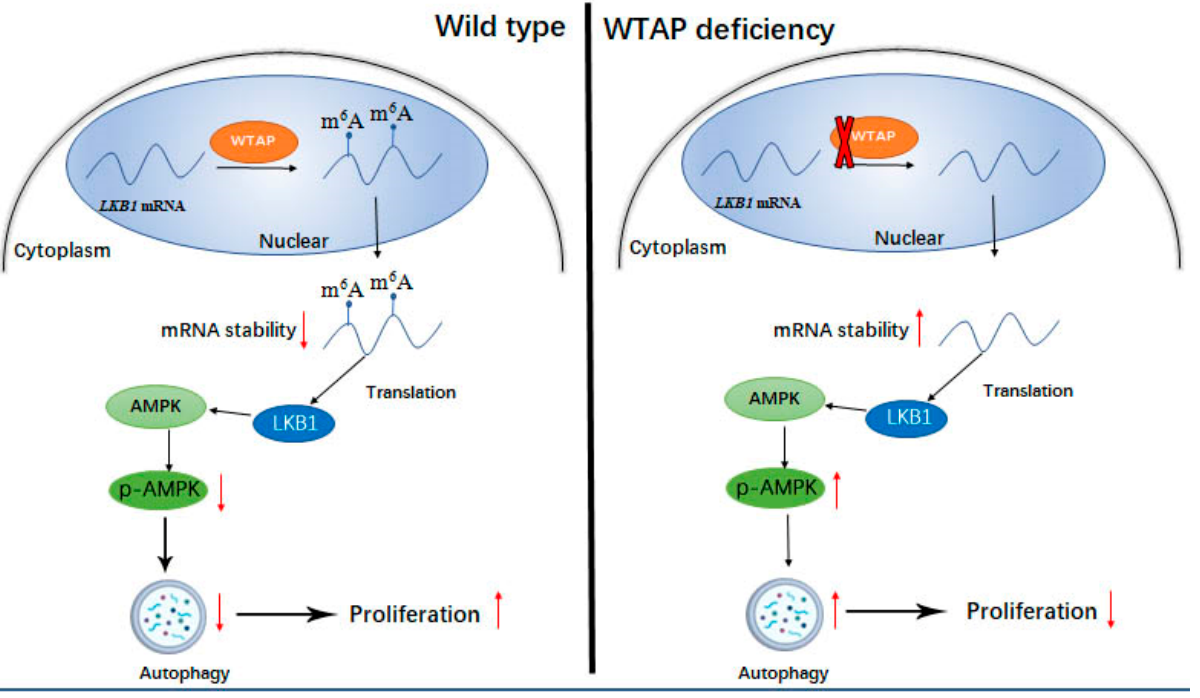
Figure 7. Schematic diagram for the regulatory role of WTAP on autophagy and proliferation of HCC, ↑ and ↓ indicating upregulation and downregulation of target proteins, respectively. WTAP expression was not knocked down in wild type HCC. WTAP deficiency indicates the knockdown of WTAP in HCC by siRNA.